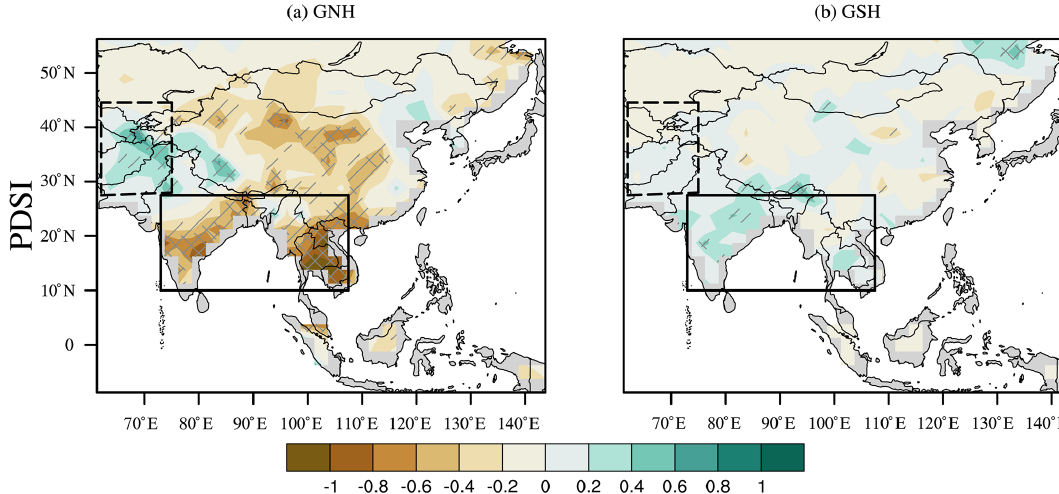
Figure 4. Spatial distribution of the Palmer Drought Severity Index (PDSI) anomalies in the eruption year with respect to the mean of 5 years before the eruption. The solid and dashed black boxes indicate the relatively wettest area (RWA) and relatively driest area (RDA), respectively, as shown in Fig. 1. The gray slashes and cross signs indicate the significant results that passed the Monte Carlo model tests at the 95% and 99% confidence levels. Table 1. Mean Pearson cross-correlation ( r ) values between near-surface air temperature ( T ), precipitation ( P ), and radiation-, heat- and moisture-related variables over the Asian monsoon region. Numbers in italics and in bold are significant at the 95% and 99% confidence